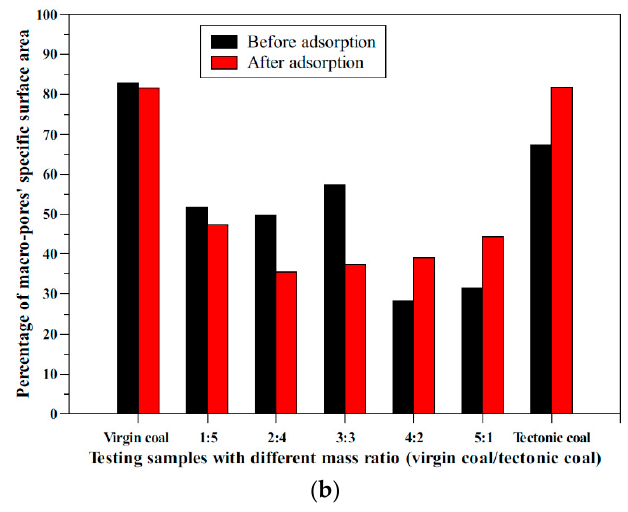
Figure 5. Percentage of macro ( a ) and micro ( b ) pores’ specific surface area before/after the adsorption test.